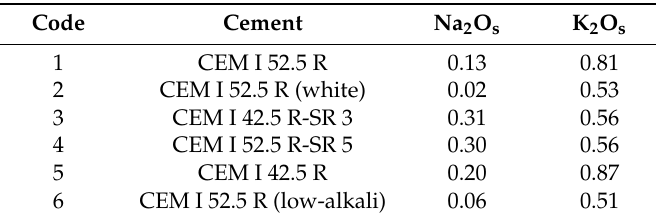
Table 3. Water-soluble alkalis determined in the cement, which are considered as cations present in sulfate form (%).